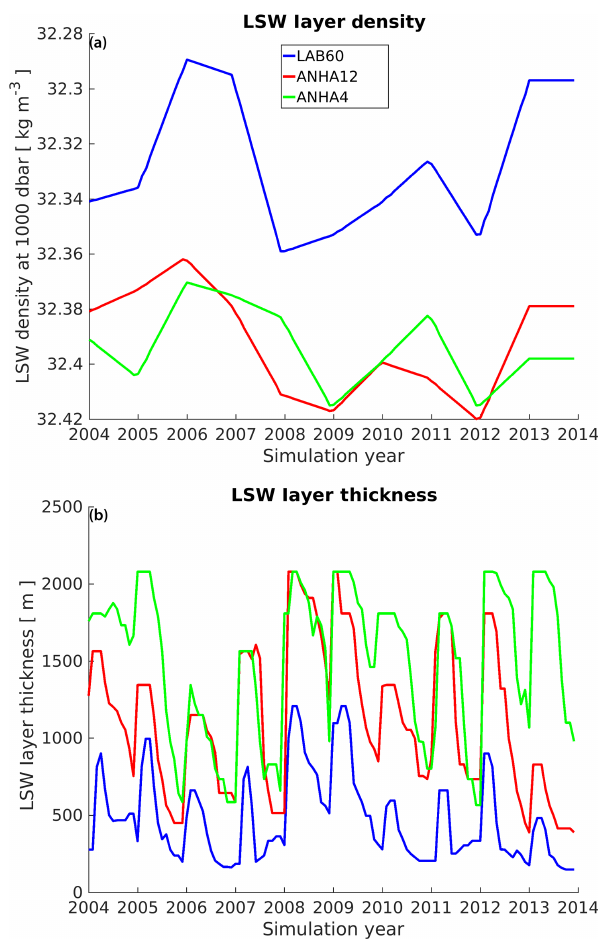
Figure 10. Labrador Sea Water (LSW) density (a) and thickness (b) for the LAB60, ANHA12, and ANHA4 configurations. LSW den- sity was determined from the thickest layer where a 0.001kgm − 3 change in potential density (ref: 1000dbar) occurred within the black polygon outlines in Fig. 1c. The LSW layer was then calcu- lated between this density and one that was 0.02kgm − 3 less